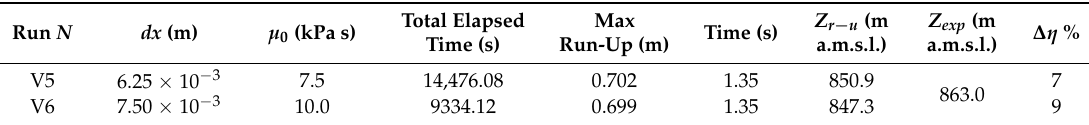
Table 5. Runs with reduced particles resolution: maximum run-up and percentage error with the experimental result.